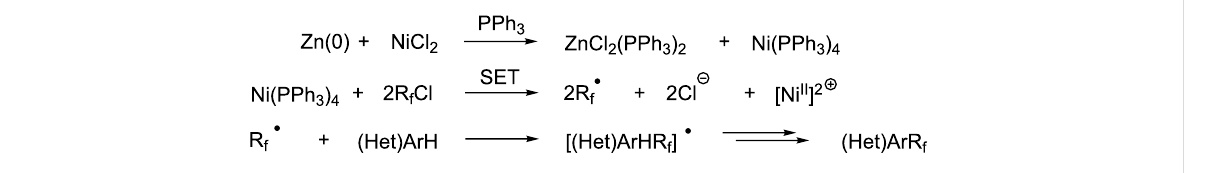
Figure 19: Mechanistic proposal for the Ni-catalyzed perfluoroalkylation of arenes and heteroarenes with perfluoroalkyl chlorides by Q.-Y. Chen and coworkers [111].